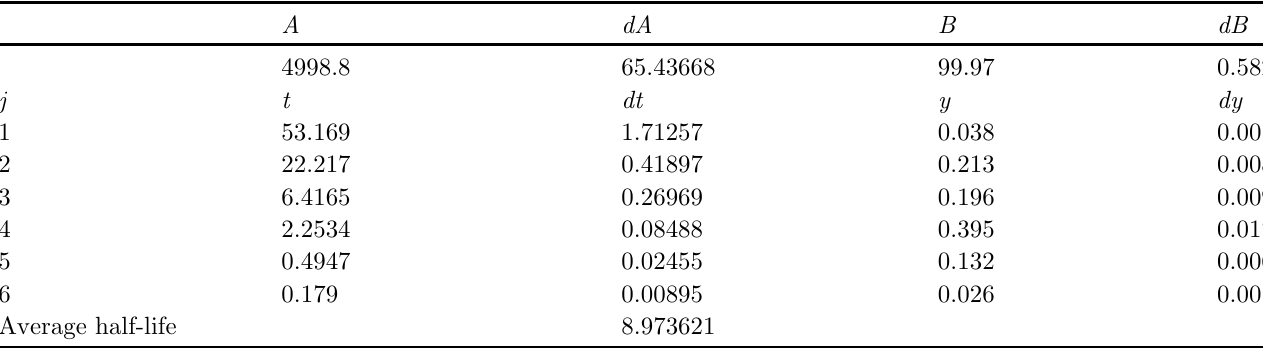
Table C7. The 6-group DN parameters ( a the help of the 6-group DN “ input dataset ” ( A = 5000; B = 100).